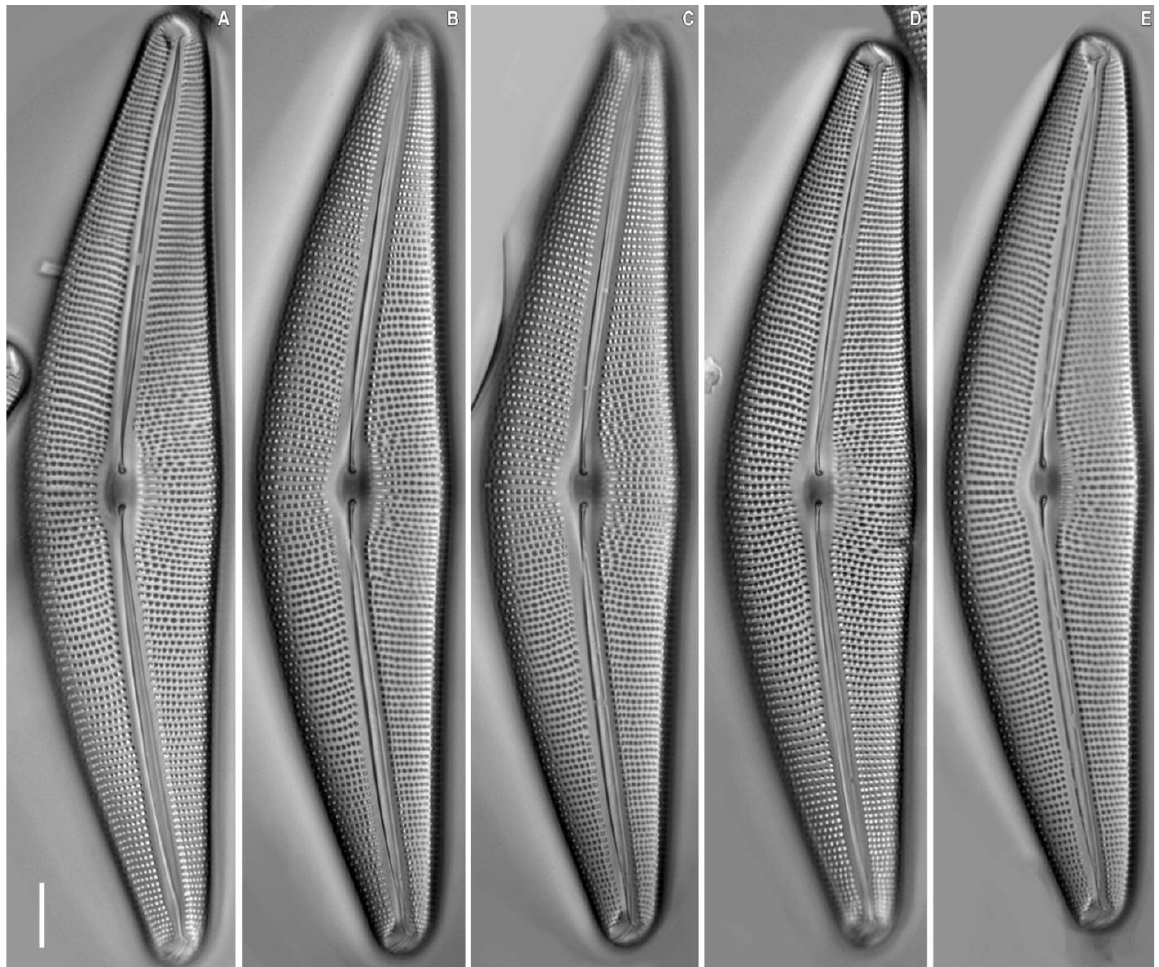
Figure 8. Cymbella baicalaspera Glushchenko, Kulikovskiy and Kociolek sp. nov. Strain B290. ( A – E ) Light microscopy, differential interference contrast, size diminution series. Slide No. B290. Scale bar = 10